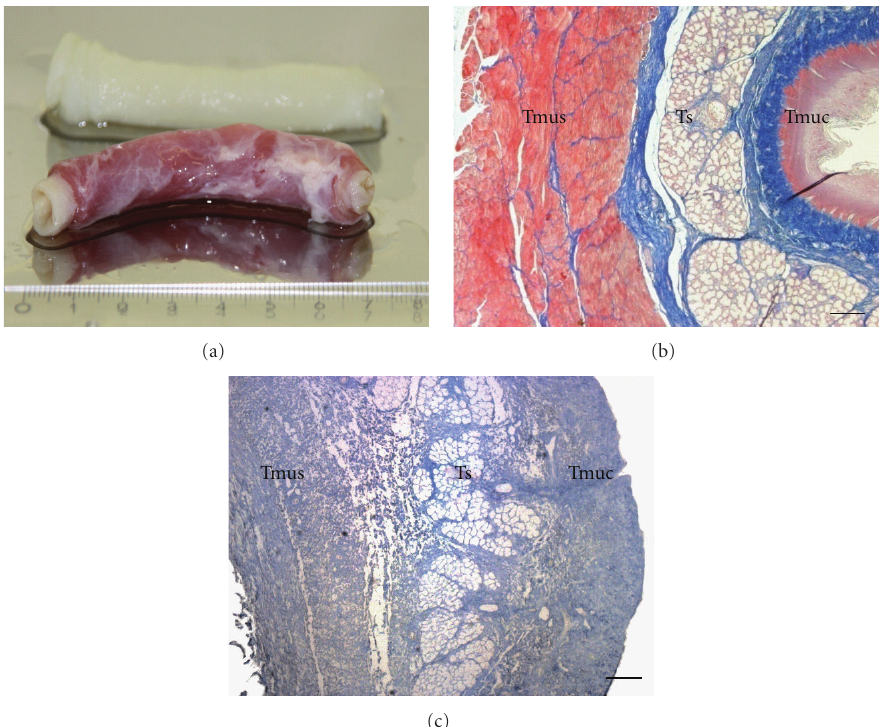
Figure 1: A representative piece of esophagus before (bottom) and after (top) decellularization (a). (b) and (c) show the tissue morphology before (b) and after decellularization (c) of porcine esophagus. Acellular esophagus sca ff olds showed anatomical intact structures, optimal matrix geometry, and no remaining cellular structures. Connective tissue was stained blue, chromatin red, muscle cells orange, and erythrocytes red. Magnification: × 40, bar = 100 μ m. Tmus: Tunica muscularis; Ts: Tela submucosa; Tmuc: Tunica